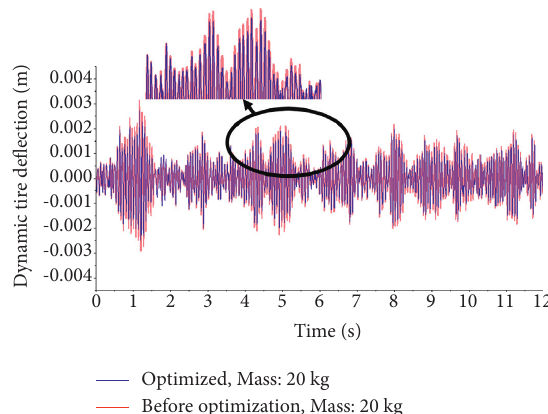
Figure 22: Comparison of the optimization results of the time-domain dynamic tire deflection at a 20kg load.